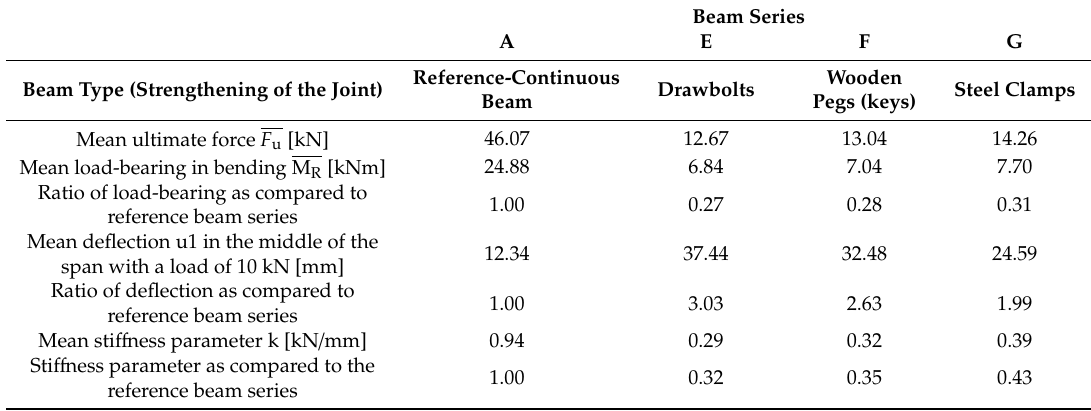
Table 3. Presentation of results for beams from specified